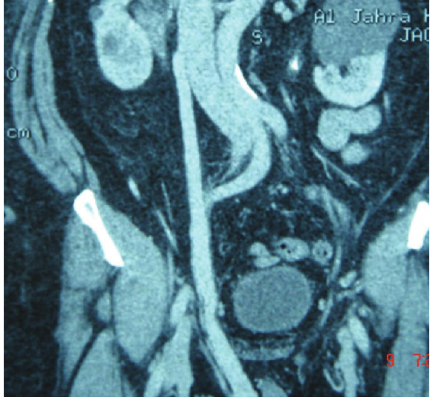
Figure 2: Abnormal communication of superior mesenteric vein and rt testicular